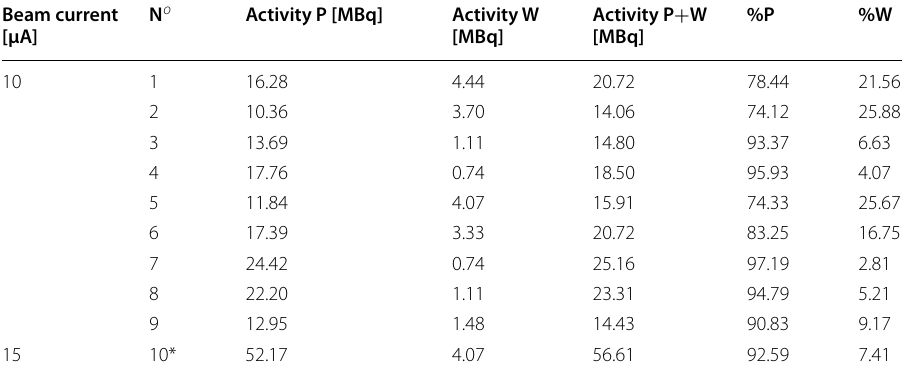
The irradiation parameters: beam current 10 μA (N o : 1–9) and 15 μA (N o : 10 denoted with *), irradiation time of 1.5 h, Havar foil thickness of 0.2 mm